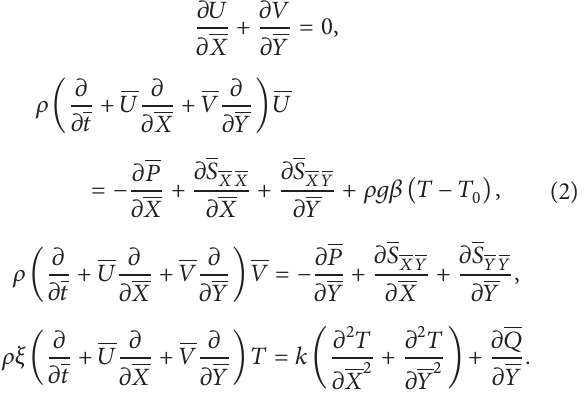
wavelength, 𝑡 is the time and 𝜙 is the phase difference with 0 ≤ 𝜙 ≤ 𝜋 , and 𝜙 = 0 gives the waves out of phase while for 𝜙 = 𝜋 the waves are in phase. Further, 𝑎 by 𝑎 2 1 +𝑎 2 2 +2𝑎 1 𝑎 2 cos 𝜙 ≤ (𝑑 1 +𝑑 2 )